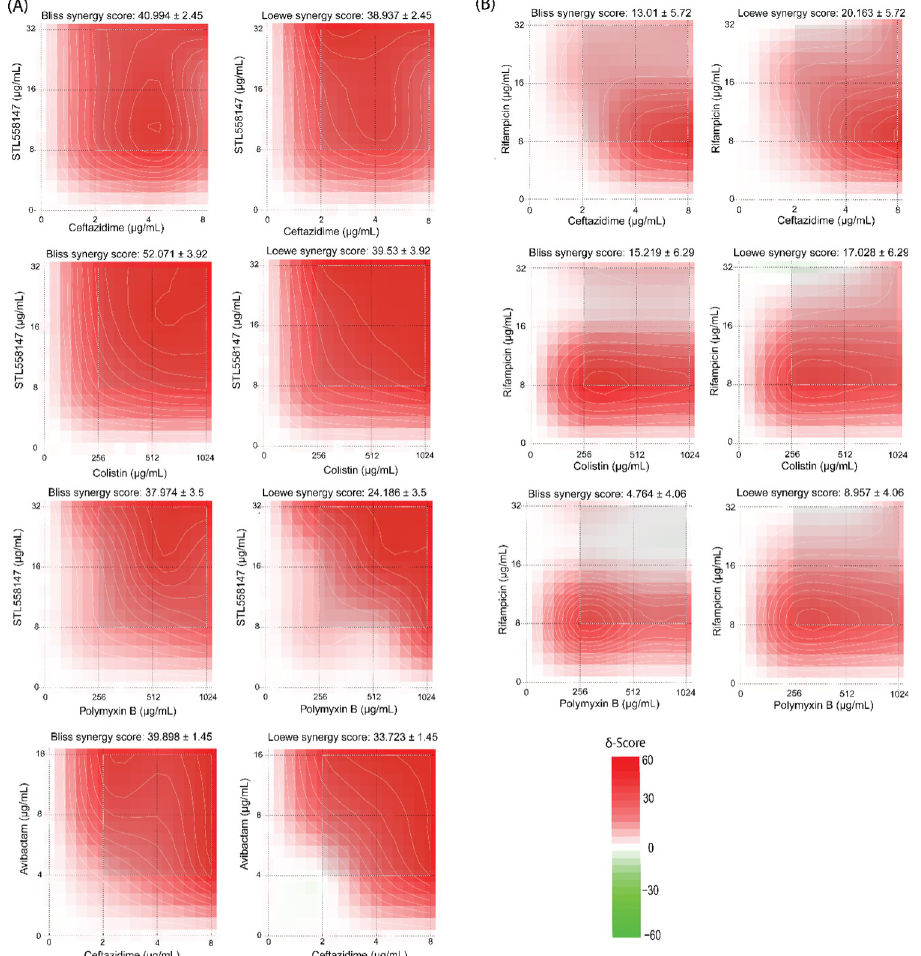
Fig 5. Synergy maps of STL558147 and rifampicin combined with other antibiotics against B . cenocepacia K56-2. Synergy plots of STL558147 (A) and rifampicin (B) with ceftazidime, colistin, and polymyxin B. The synergy scores were calculated based on the widely used Bliss independence [52] and Loewe additivity [53] models. The most synergistic area in each combination is highlighted with a rectangular box inside the plot. Green (negative δ -scores) indicate antagonistic interactions, and red (positive δ -scores) indicate synergistic interactions. Synergy scores > 15, between -5 to 15, and < -15 were considered synergistic, additive and antagonistic, respectively. Results are average of at least three independent biological replicates. Synergy scores are shown as mean ± SEM. Synergy scores were calculated using SynergyFinder 2.0 [31].